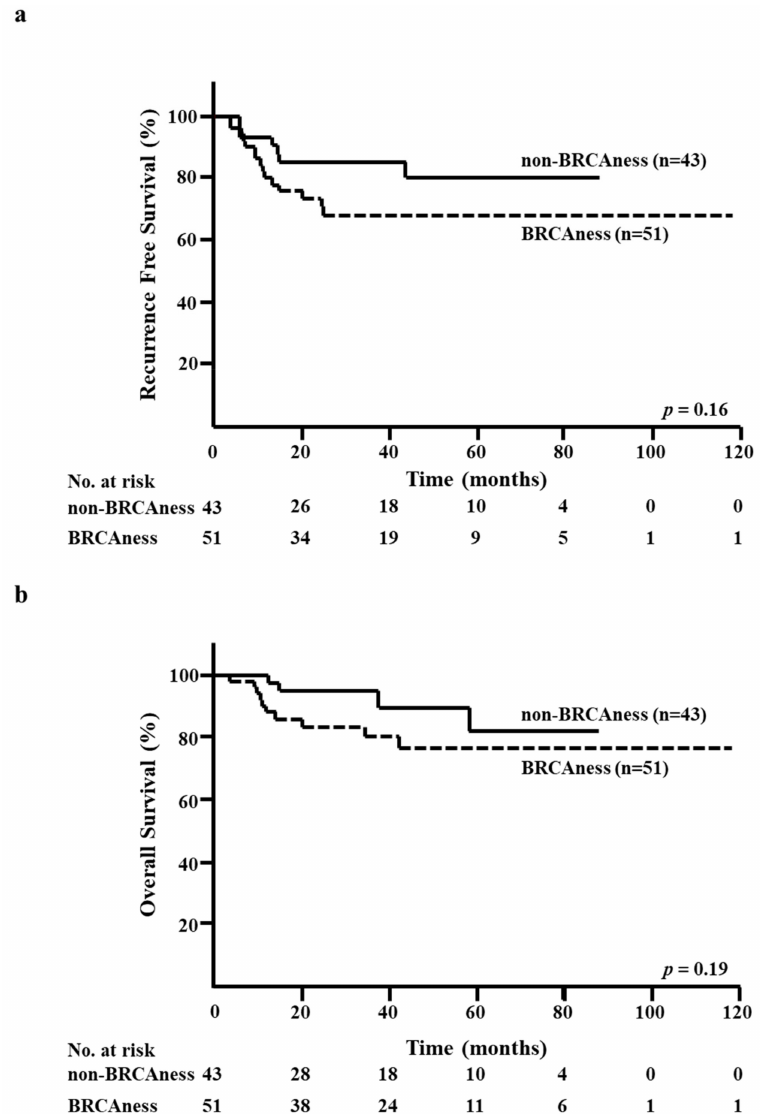
Figure 2. Kaplan–Meier analysis according to the BRCAness of core needle biopsy (CNB) specimens. ( a ) Recurrence-free survival (RFS) in the BRCAness and non-BRCAness groups. ( b ) Overall survival (OS) in the BRCAness and non-BRCAness